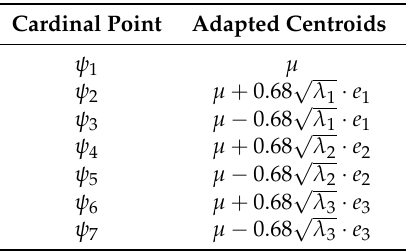
Table 1. Seven cardinal points ψ i . µ is the centroid of the contaminated dataset; e 1 , e 2 and e 3 are dataset eigenvectors corresponding to λ 1 , λ 2 and λ 3